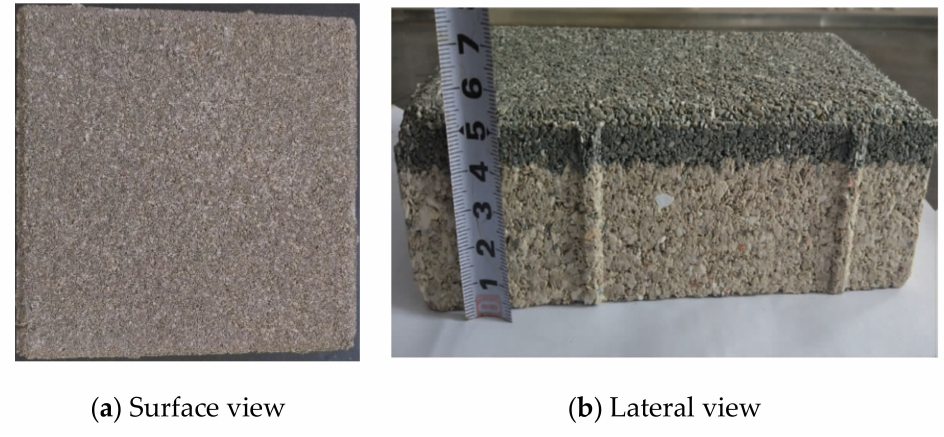
Figure 1. Ceramic permeable